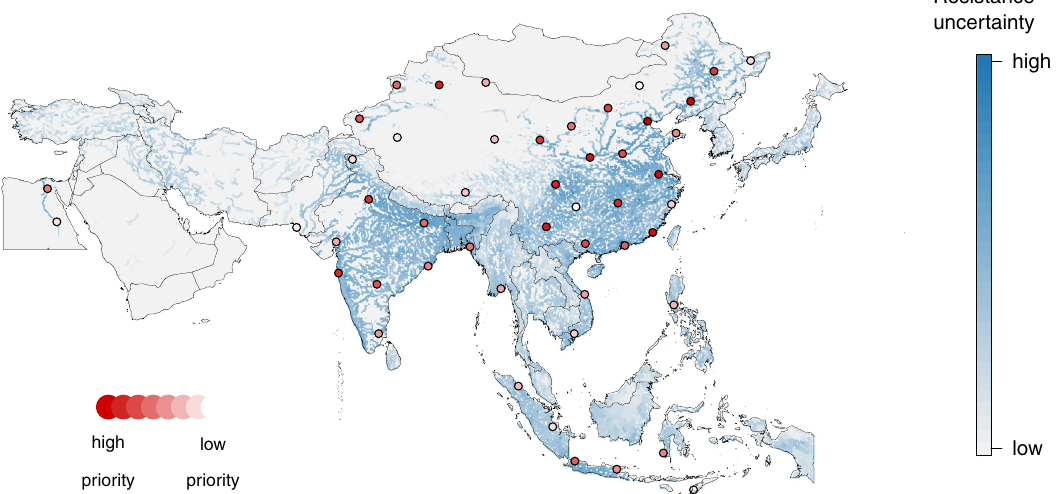
Fig. 4 Future survey locations prioritized to reduce uncertainty in antimicrobial resistance in freshwater environments in Asia. The background color gradient (blue) represents weighted uncertainty in multi-drug resistance (see “ Methods ” section). An initial set of 50 future surveys optimized to reduce uncertainty in multi-drug resistance is displayed (red).